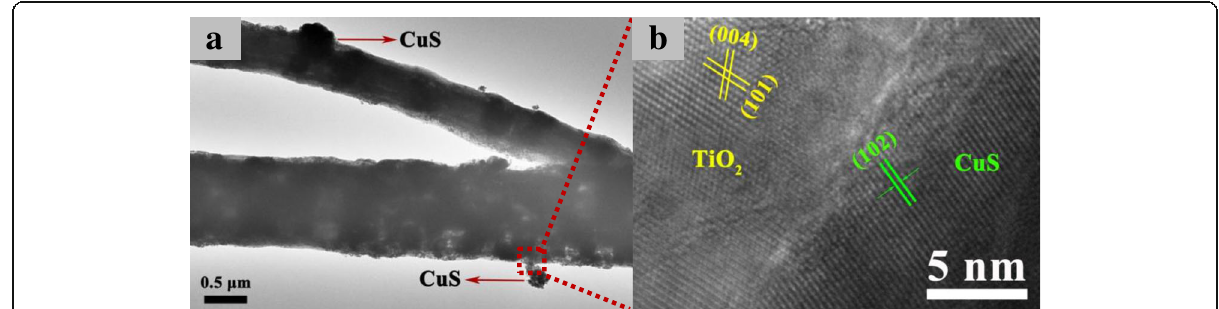
Fig. 3 TEM image of Cu 1 a and high-resolution TEM image of Cu 1 b